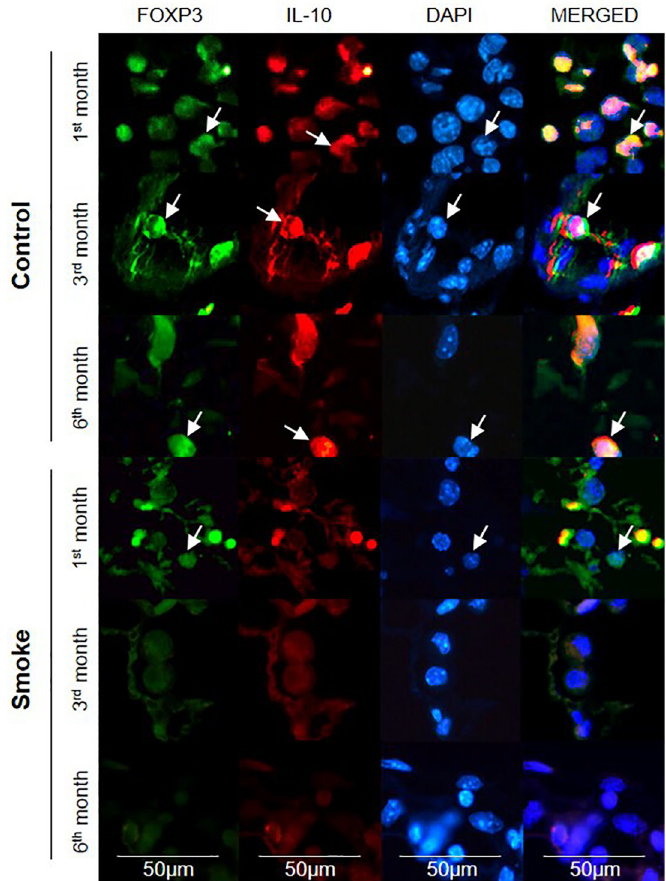
Fig 13. Representative immunofluorescent images showing FOXP3 and IL-10 staining. The expression of FOXP3 (green) and IL-10 (red) in lymphocytes that infiltrated the peribronchovascular areas of the Control and Smoke groups after 1, 3, and 6 months was assessed by double-label immunofluorescence. The nuclei were labeled with DAPI (blue), and the arrows indicate positive cells. The images are shown at 400 × magnification.